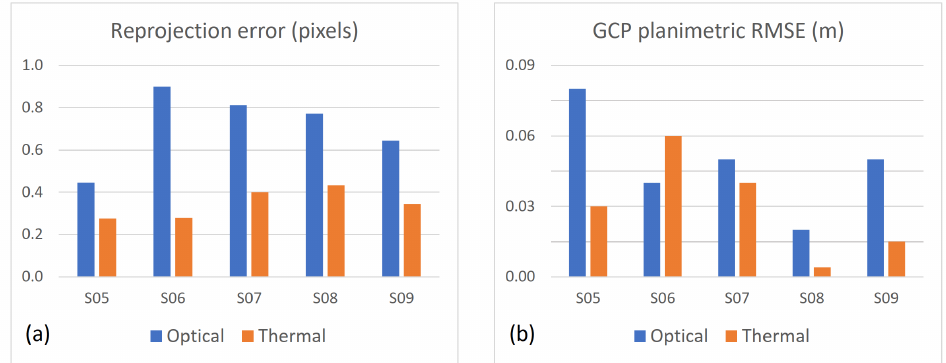
Figure 8. Comparison between ( a ) the reprojection errors (in GSD units) and ( b ) GCP residuals in planimetry (in metres), computed for RGB and thermal images for all the